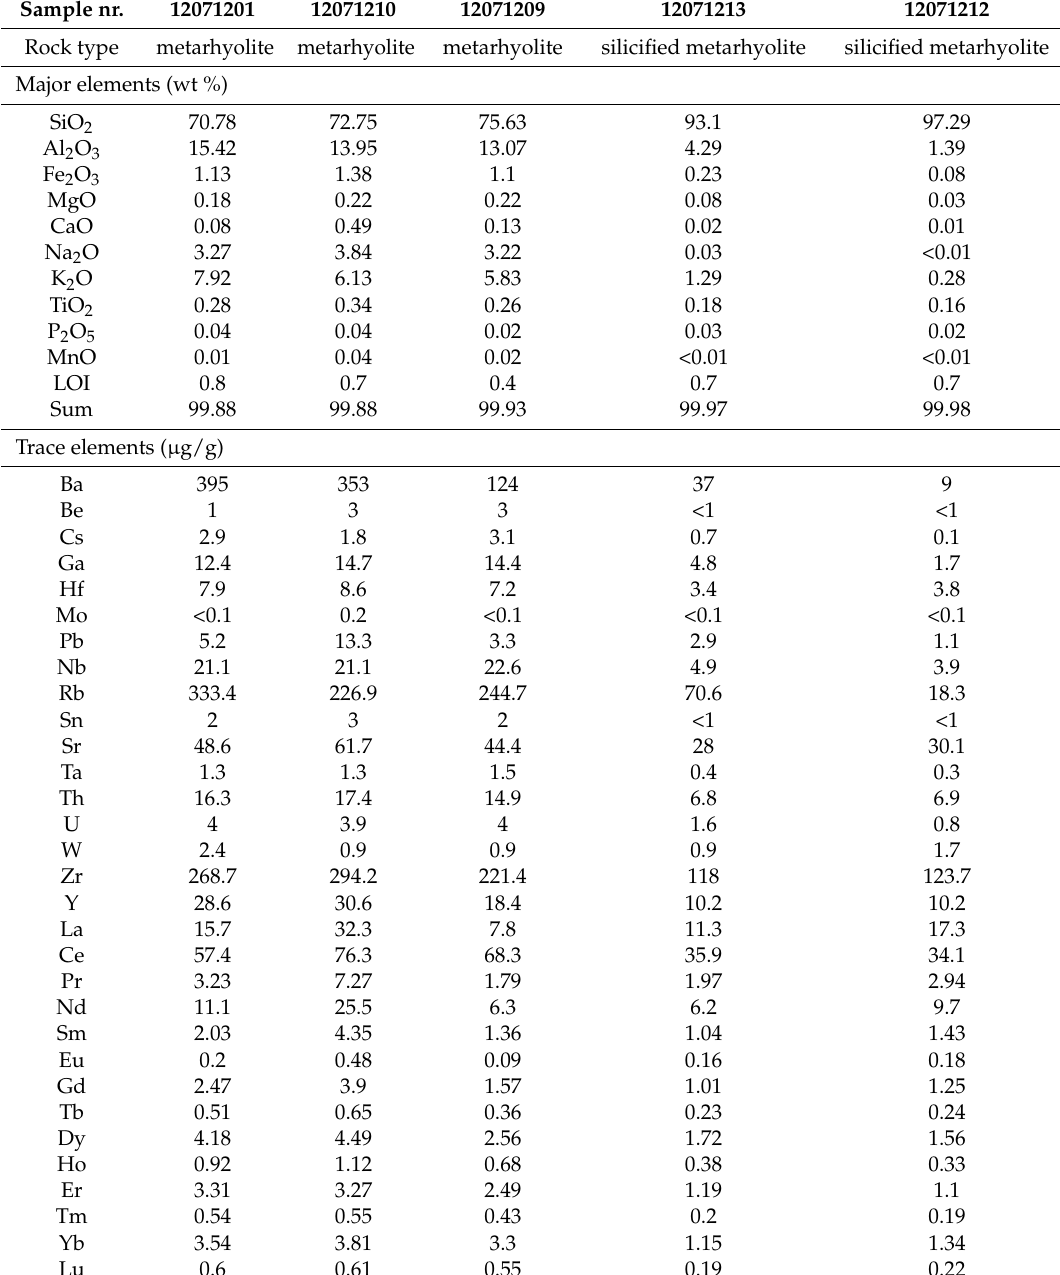
Table 1. Bulk analyses of metarhyolite, the host rock of the Berglia-Glassberget breccia. Analyses were performed at ACMELabs